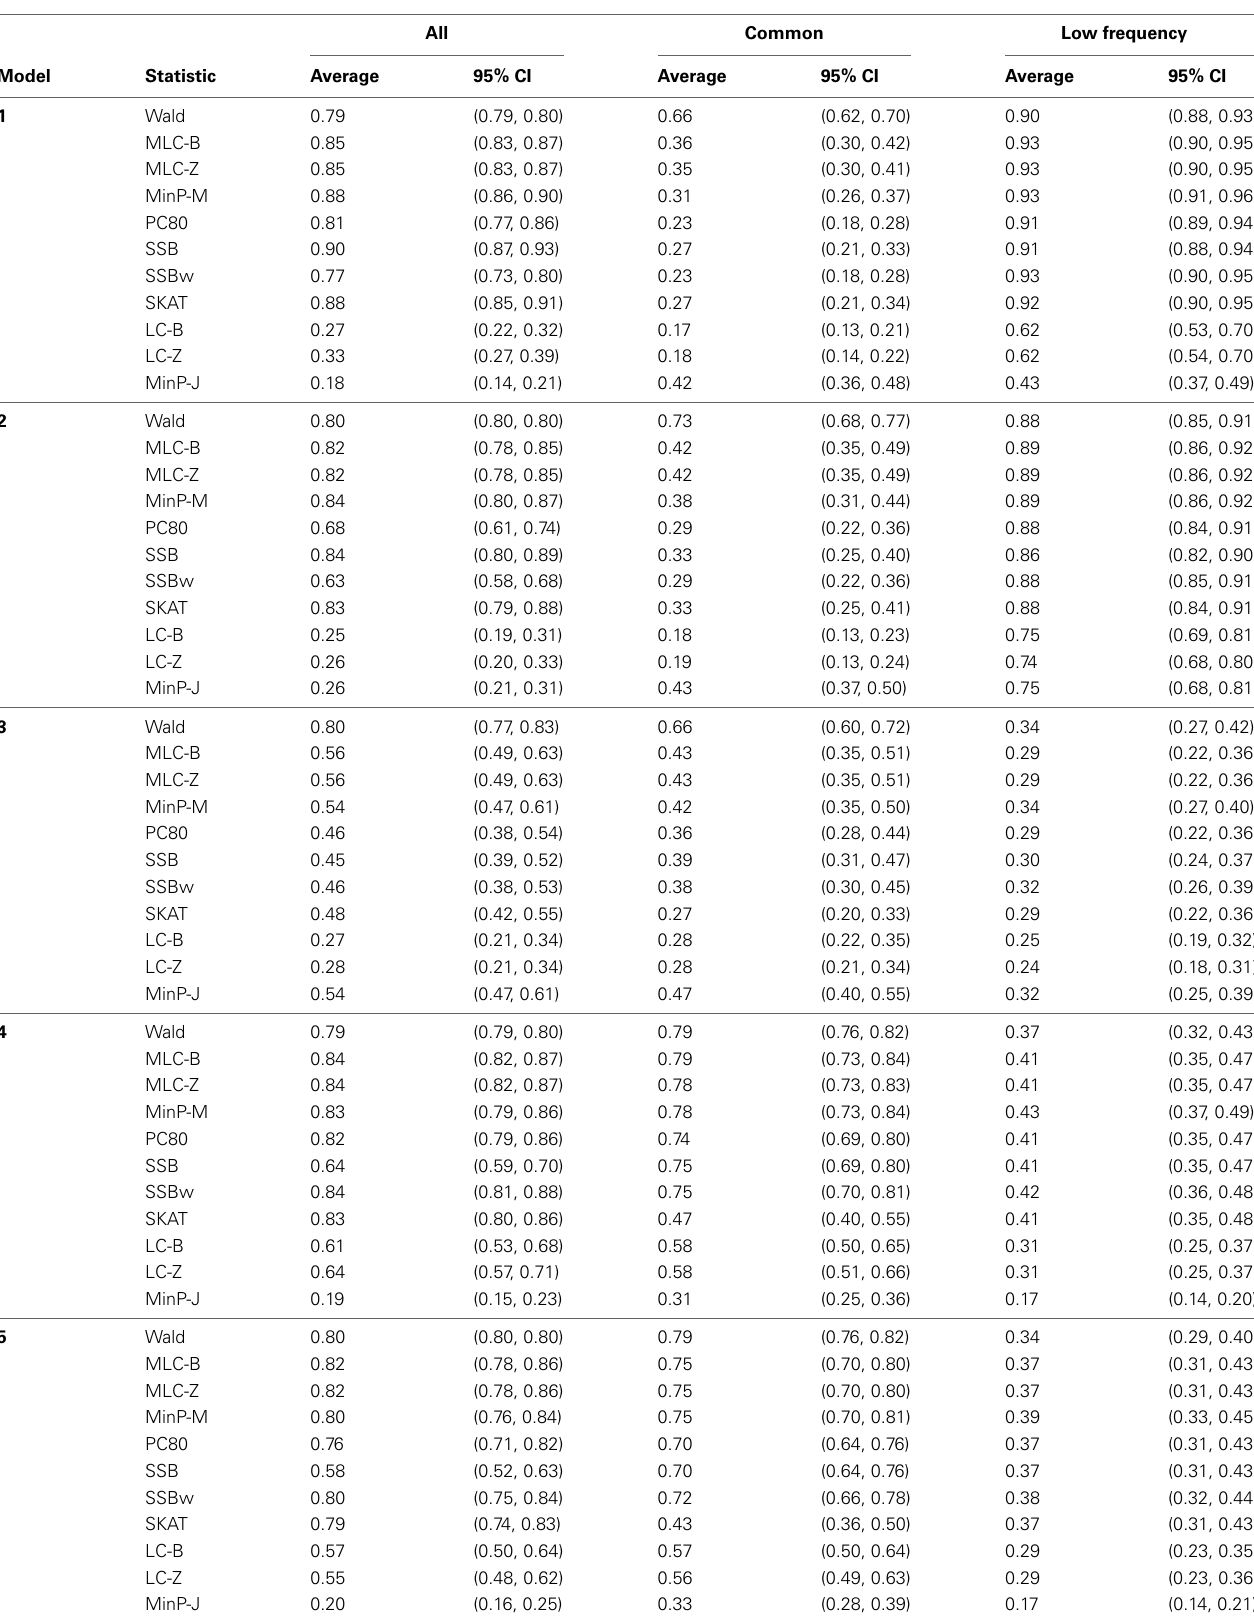
Table 5 | Empirical power of gene-based statistics ( N = 1000 replicates) at the 0.05 level for three analysis sets, averaged over 85